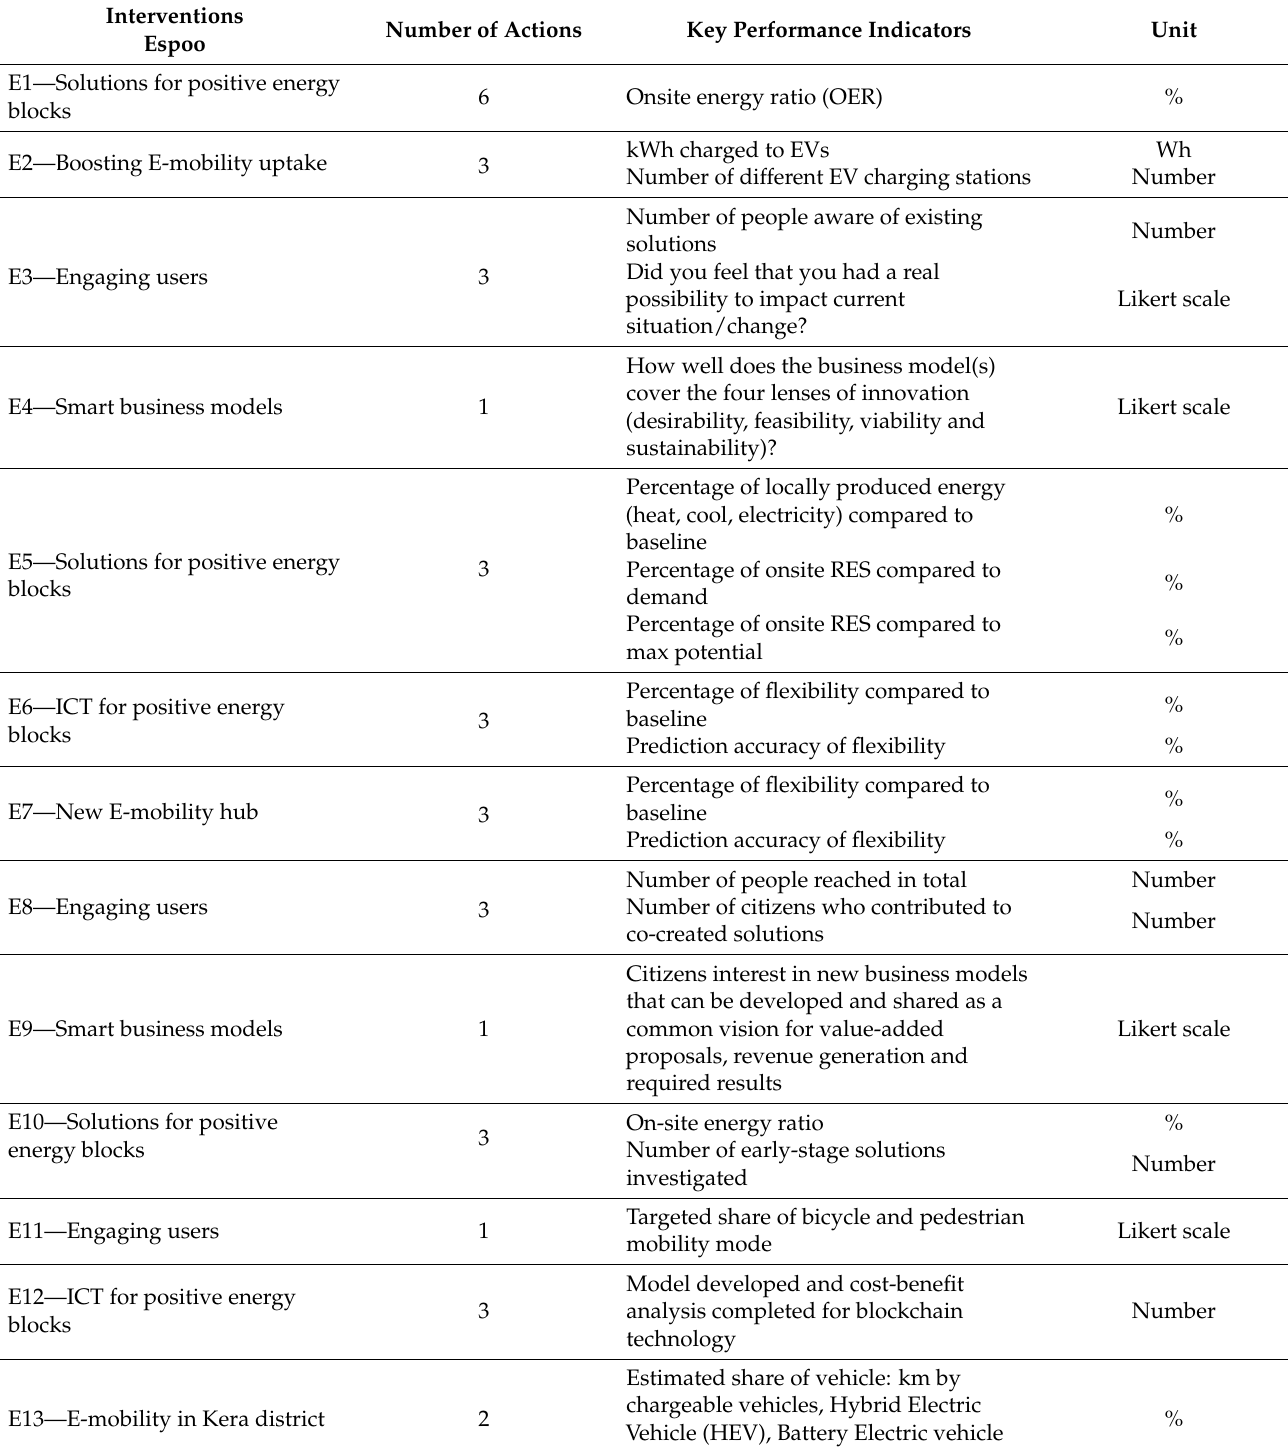
Table 4. Bottom-up